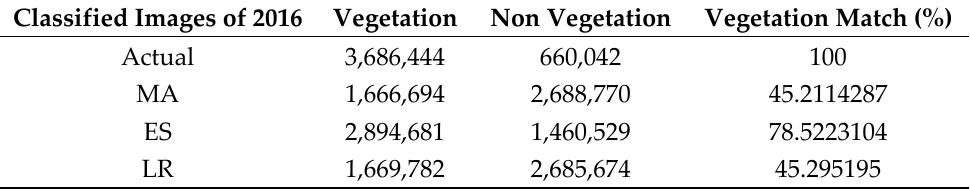
Table 1. Vegetation match in percentage of actual image with forecasted images of the year 2016.